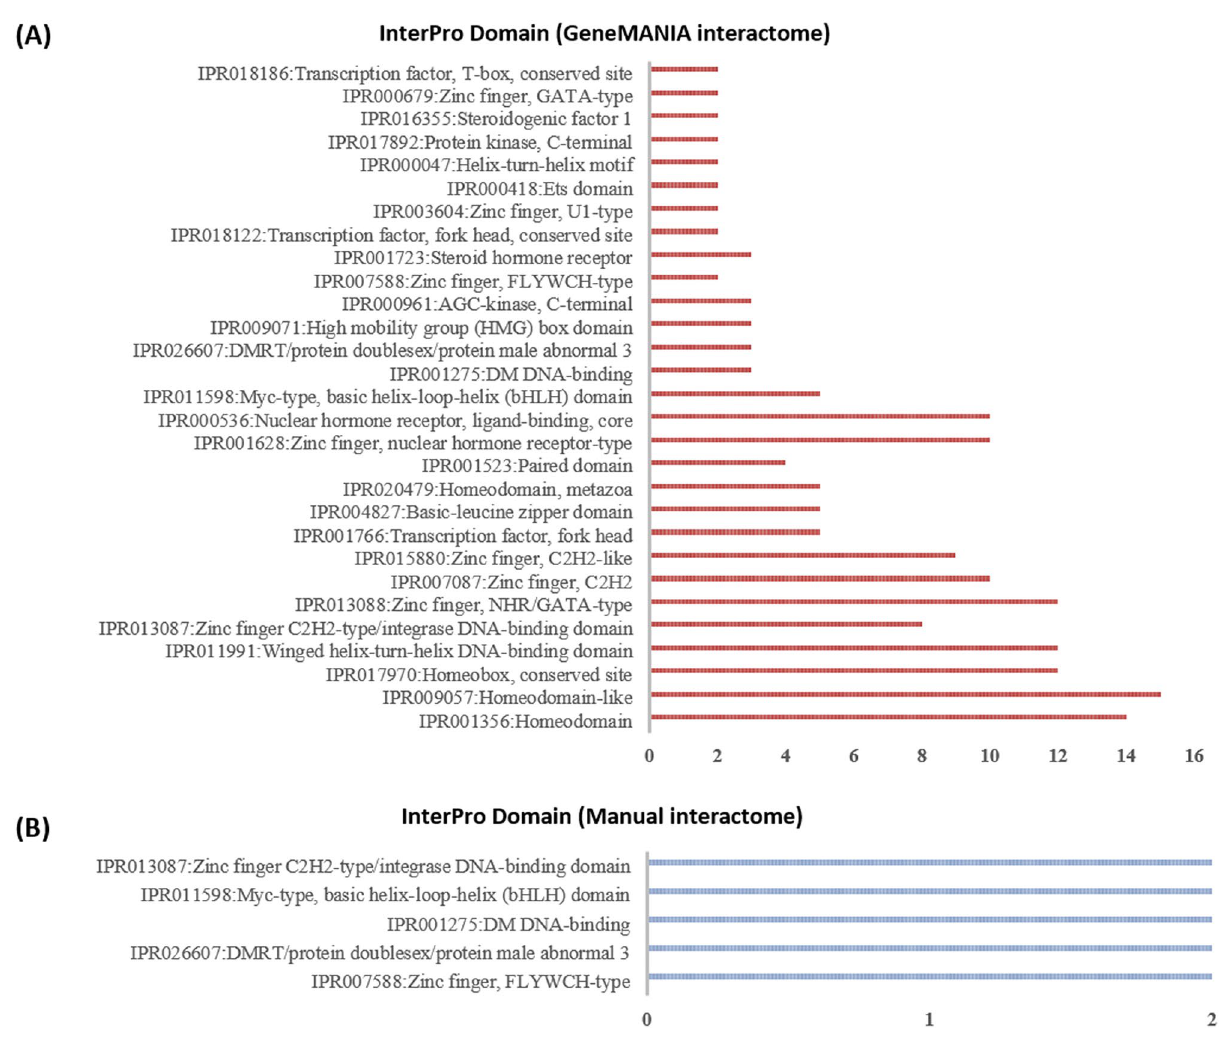
Figure 5. InterPro domain analysis of protein interactome of C. elegans SIN-3 protein, obtained from ( A ) GeneMANIA database and ( B ) direct evidence method using the NIH LHRI DAVID 6.8 service. The y-axis represents the InterPro domains, while the x-axis represents the number of proteins associated with a particular